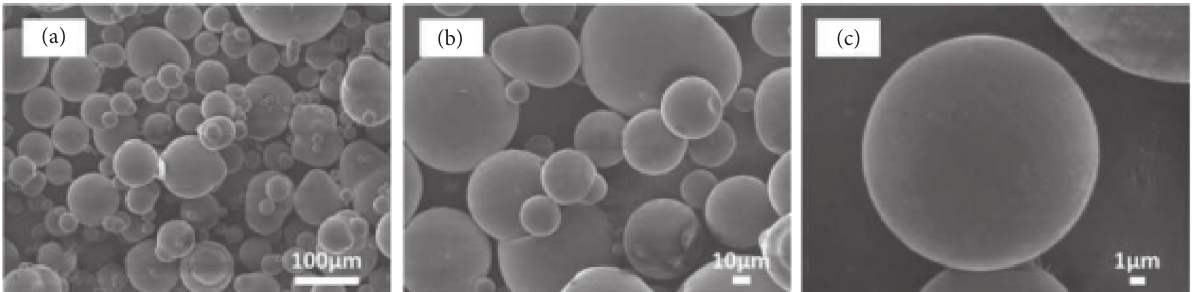
Figure 2: (a) SEM image of hollow phenolic microspheres under 200 times magnification; (b) SEM image of hollow phenolic microspheres under 1000 times magnification; (c) SEM image of hollow phenolic microspheres under 4000 times magnification.